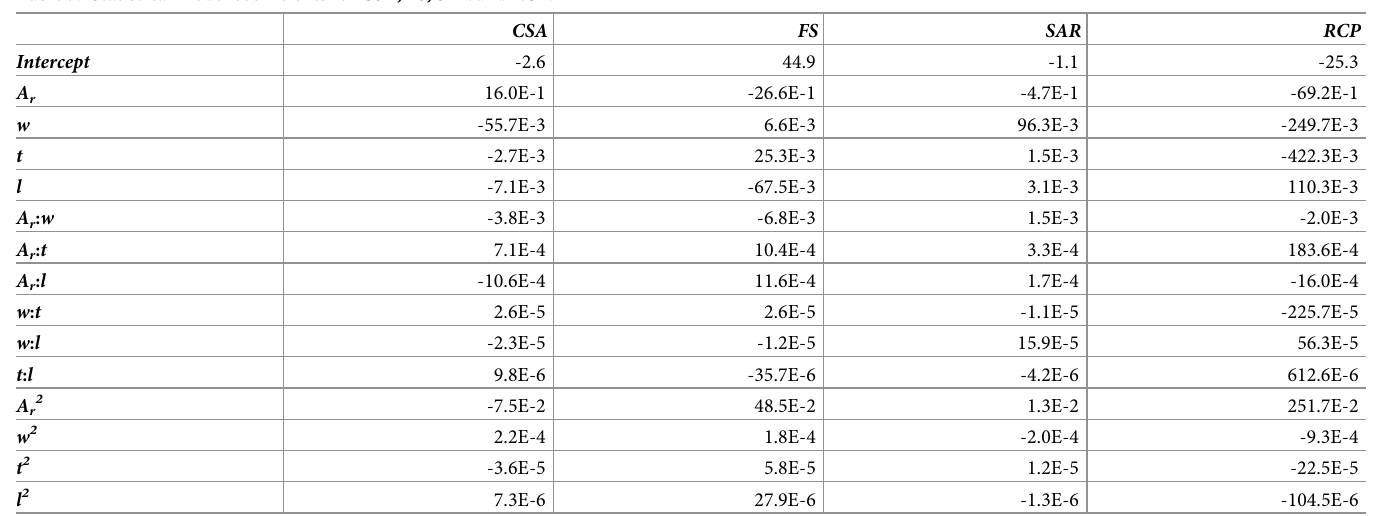
Table 5. Statistical model coefficients for CSA , FS , SAR and RCP .